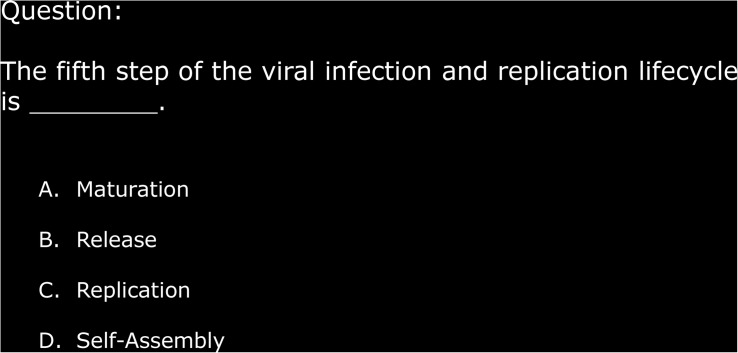
A sample of the multiple-choice questions (MCQs).